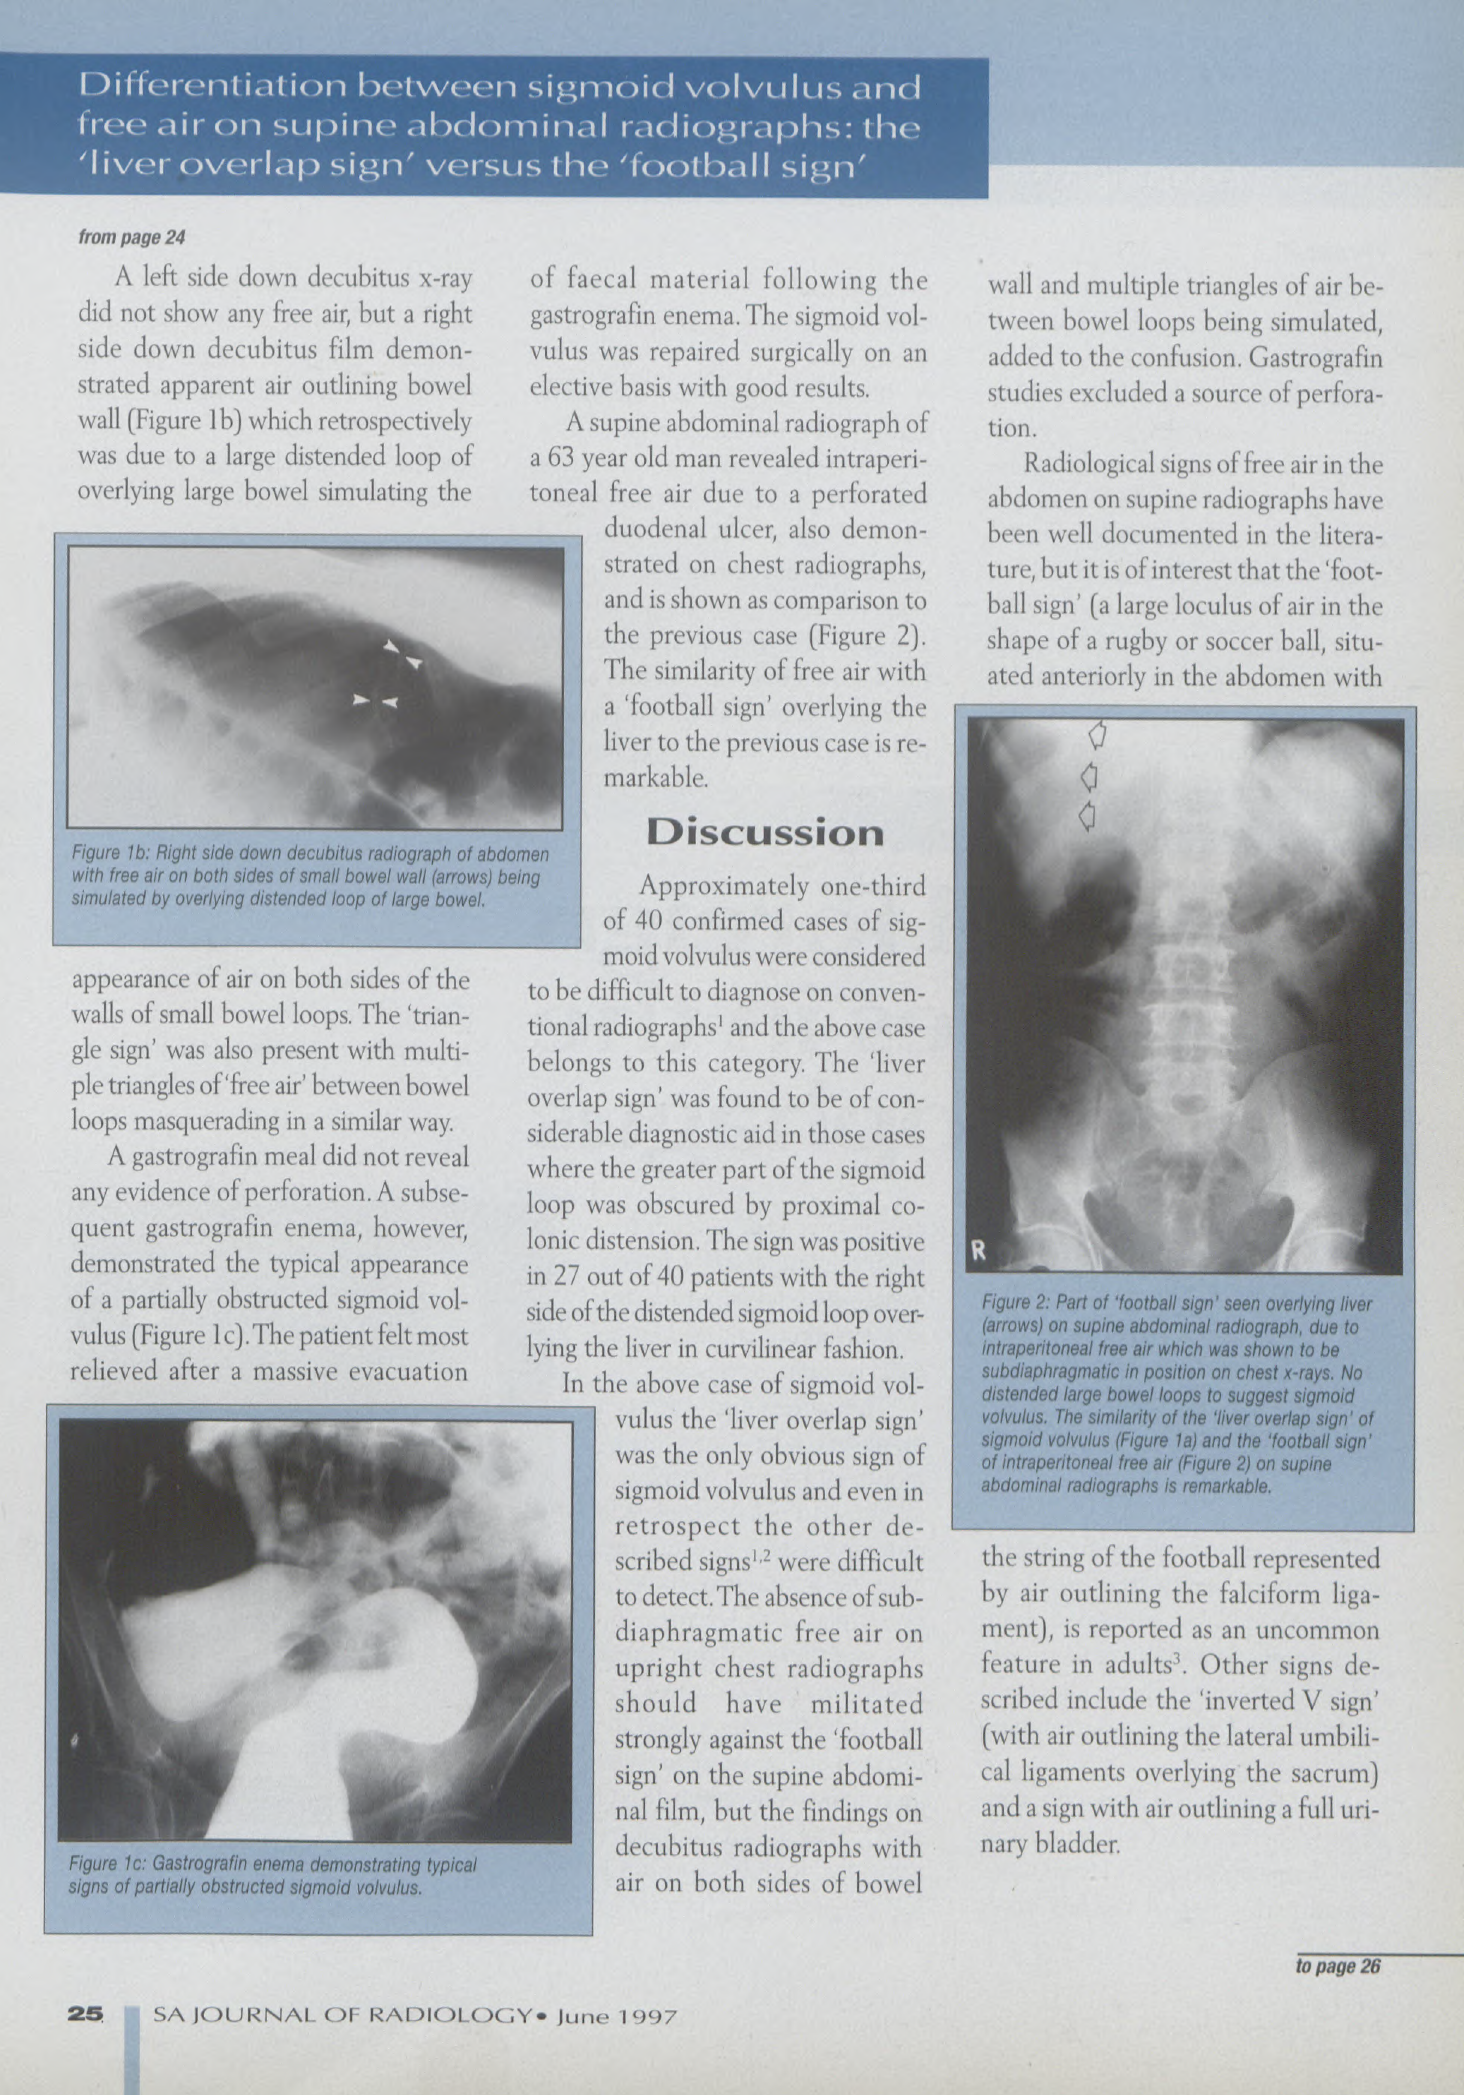
Figure 2: Part of 'football sign'seen overlying liver (arrows) on supine abdominal radiograph, due to intraperitoneal free air which was shown to be subdiaphragmatic in position on chest x-rays. No distended large bowel loops to suggest sigmoid volvulus. The similarity of the 'liver overlap sign' of sigmoid volvulus (Figure la) and the 'football sign' of intraperitoneal free air (Figure 2) on supine abdominal radiographs is